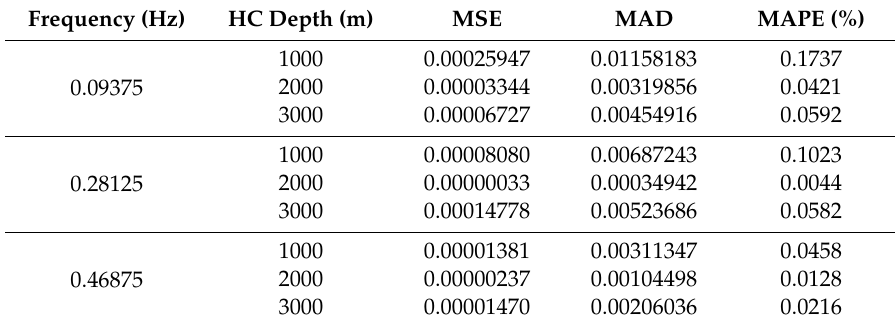
Table 3. Forecast error measurement for the three untried transmission frequencies (0.09375 Hz, 0.28125 Hz, and 0.46875 Hz) at all tested depths of hydrocarbon (1000 m, 2000 m, and 3000 m from the seabed). Frequency (Hz) HC Depth (m)